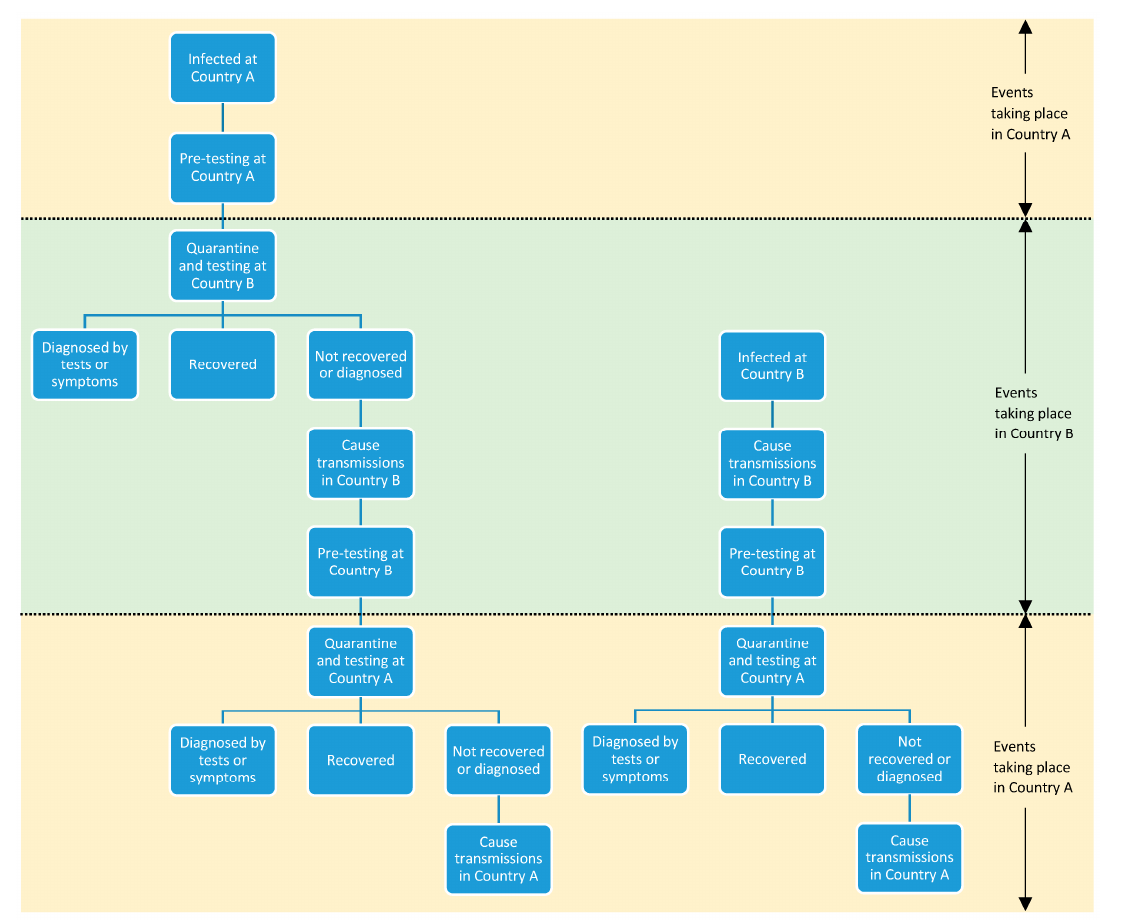
Figure 2. Transmission diagram of a round trip from Country A to Country B. The left diagram illustrates the possible itineraries of the cohort infected in Country A (home country) before they start the trip. The right diagram illustrates the possible itineraries of the cohort infected in Country B (destination country).